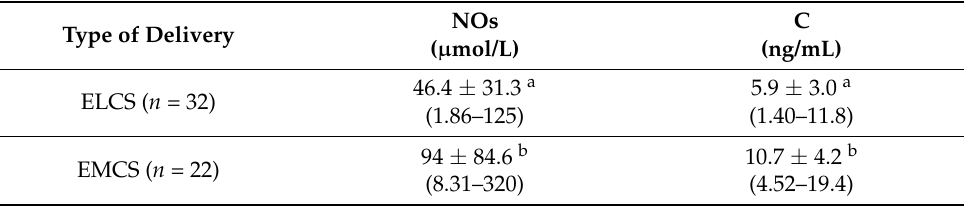
Table 2. Descriptive data expressed as mean ± SD and (min-max) about NOs and C amniotic concentrations in the 32 puppies delivered by elective Caesarean section (ELCS) and in the 22 puppies delivered by emergency Caesarean section (EMCS).